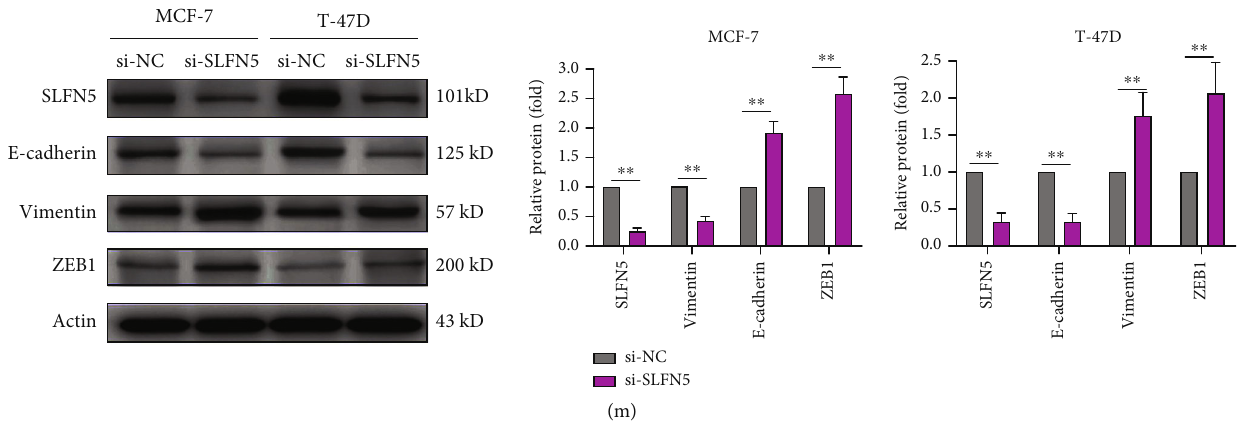
Figure 3: MEG3 represses BRCA cell migration, invasion, and EMT. (a, b) Morphological changes responding to si-MEG3 or si-NC interference (a) and MEG3 plasmid transfection (b) in indicated BRCA cells. (c, d) Relative mRNA level change of EMT molecular markers, vimentin, E-cadherin, and ZEB1, responding to si-MEG3 interference (c) or MEG3 plasmid transfection (d) in indicated BRCA cells. (e, f) Western blotting analyses of protein change of EMT markers responding to si-MEG3 transfection (e) or MEG3 plasmid transfection (f). (g – j) Cell migration and invasion capabilities evaluated by transwell assays responding to si-MEG3 (g, h) or MEG3 plasmid transfection (i, j). (k) Morphological changes of MCF-7 and T-47D cells responding to si-SLFN5 or si-NC interference. (l, m) Real-time and Western blotting analyses of vimentin, E-cadherin, and ZEB1, responding to si-SLFN5 or si-NC interference. ∗ P < 0 : 05 , ∗∗ P < 0 : 01